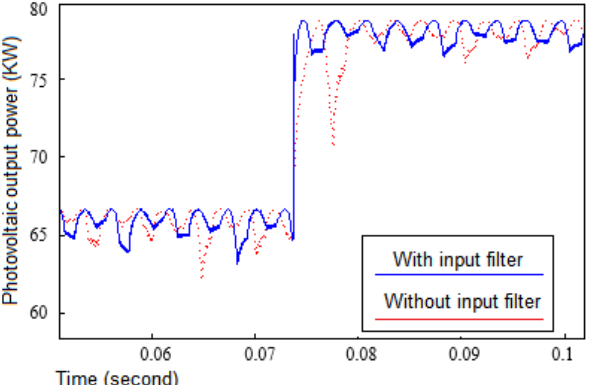
Figure 12. The generated PV power under a nonlinear time–variant load while a sudden light intensity variation (1000–1200 W/m 2 ) occurs at 0.075 s.